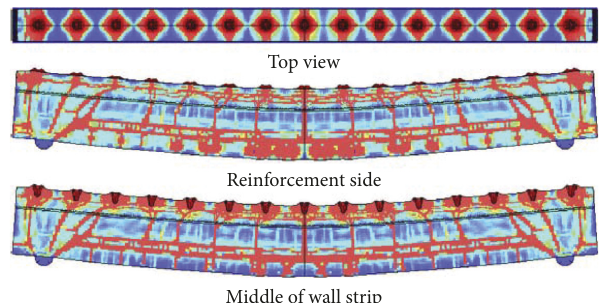
Figure 16: Damage in RC wall strip loaded with simultaneous blast and fragmented impact loads